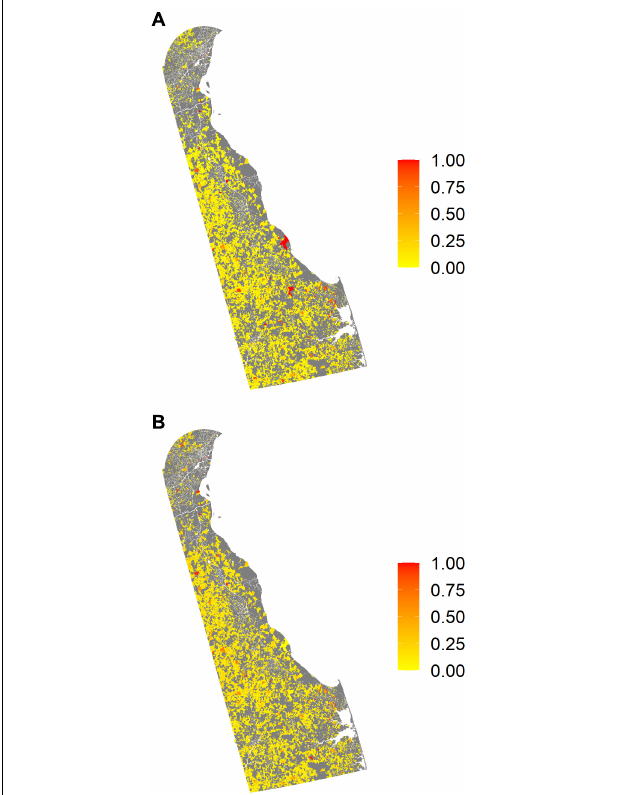
FIGURE 4 | Predicted probability of commercial forest harvest by family forest ownerships across Delaware, United States. (A) Shows the probability of commercial harvest in the previous 5 years. (B) Shows the width of the 95% credible interval. Null values are represented in gray and correspond to public ownerships, corporate ownerships, other non-family private ownerships, and family ownerships owning less than one acre of forest. Values at the scale of the individual pixel reflect harvest probabilities across the entire parcel, regardless of whether the specific pixel is forest or non-forest.